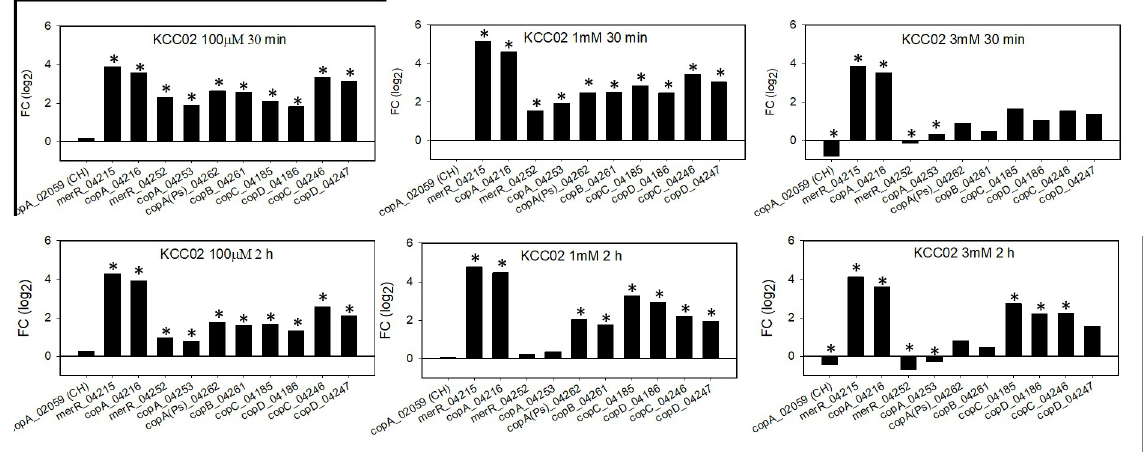
Fig 6. KCC02 expression profiling with subset of copper-associated homologs from E . coli Cue and Pseudomonas Cop systems under a range of copper concentrations. Overnight cultures were diluted 1:100 into Burkholder’s B medium and incubated for 6 h, whereupon copper was added to final concentrations of 100 μ M, 1mM, and 3mM. Samples were collected at 30 min and 2 h for expression profiling. copA(Ps) = designates copA of P . syringae system, of which copB , C , and D also belong. CH indicates gene is located on the CUKW chromosome. Genes are presented in the same order as for Fig 5 (CUKW) and are homologous to those in CUKW but are referred to by their loci. Refer to Table 3 for corresponding CUKW-KCC02 loci names. Gene expression was calculated using the ΔΔ C T method, with expression normalized to the reference gene pfk . Fold-change presented as log 2 -transformed values. � indicates significant difference between treatment (100 μ M, 1 mM, or 3 mM copper, as designated in each panel) and control (no copper) at 30 min and 2 h (p < 0.05).